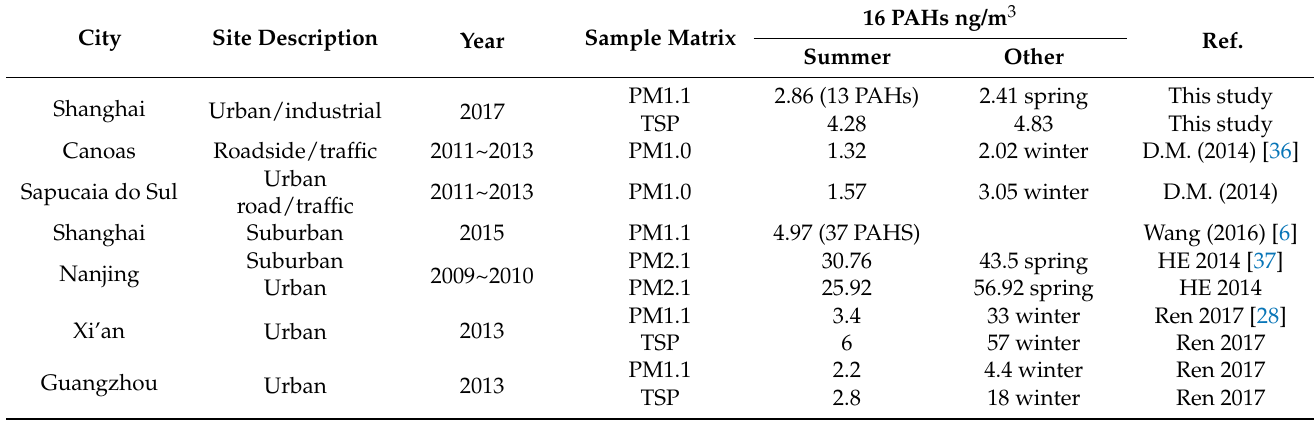
Table 2. PAHs concentrations in particulate samples in the previous studies.